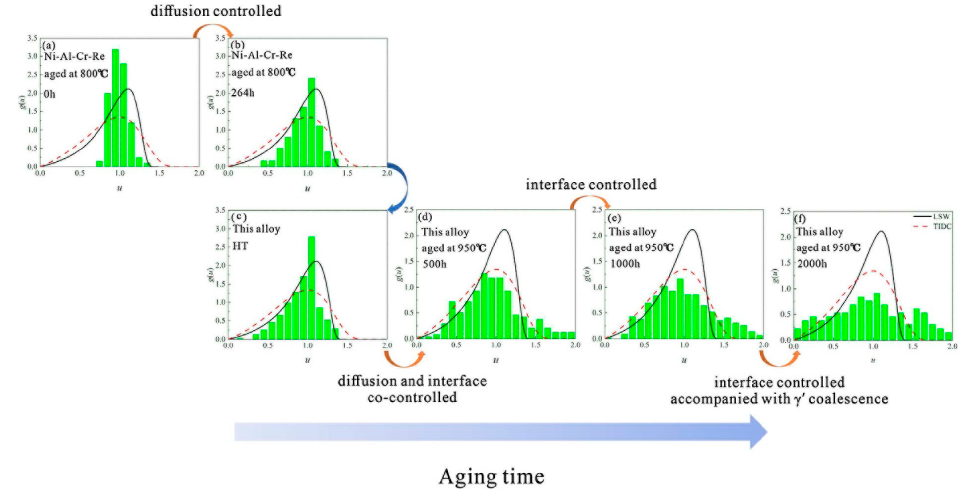
Figure 5. PSDs for Ni-Al-Cr-Re aged for ( a ) 0 h and ( b ) 264 h at 800 °C and PSDs for investigated alloy for ( c ) HT state and aged for ( d ) 500 h, ( e )1000 h and ( f) 2000 h at 950 °C [44]. ( 𝑢 represent the normalized γ ’ size).